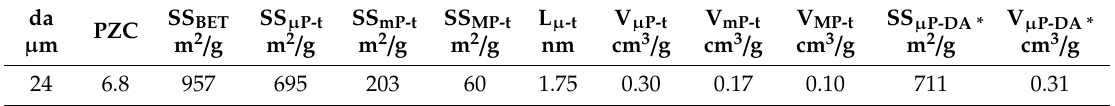
Table 1. Main characteristics of ACP Norit SA Super.